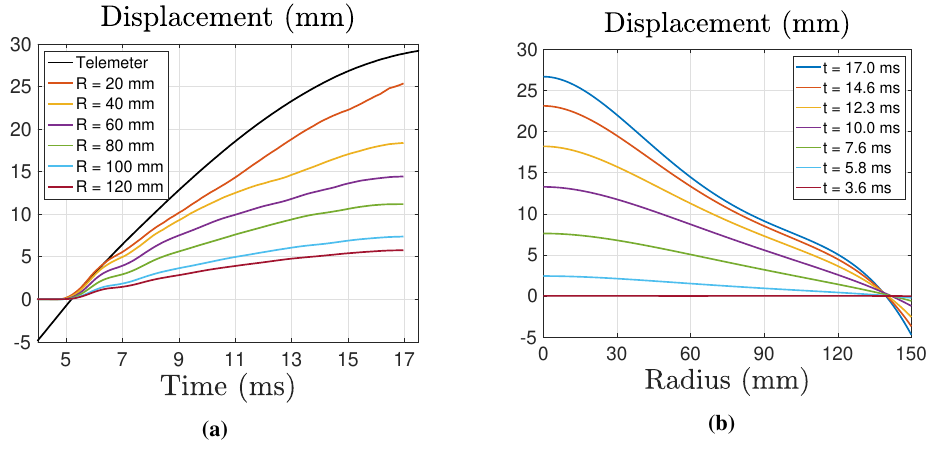
Fig. 5. Extrapolated out-of-plane displacement measured via axisymmetric stereo-D.I.C. (a) Out-of-plane displacement versus time, including the displacement measurement by the telemeter (corresponding to R = 0 mm). (b) Out-of-plane displacement extrapolation versus